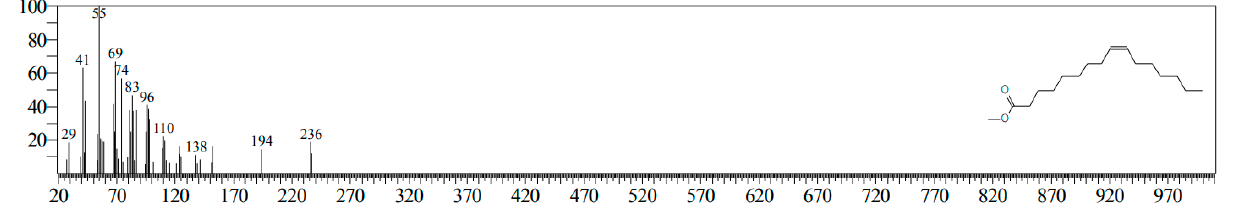
Figure 9. Comp Name: 9-Hexadecanoic acid, methyl ester, Run Time: 15.167, Mol Weight: 268.